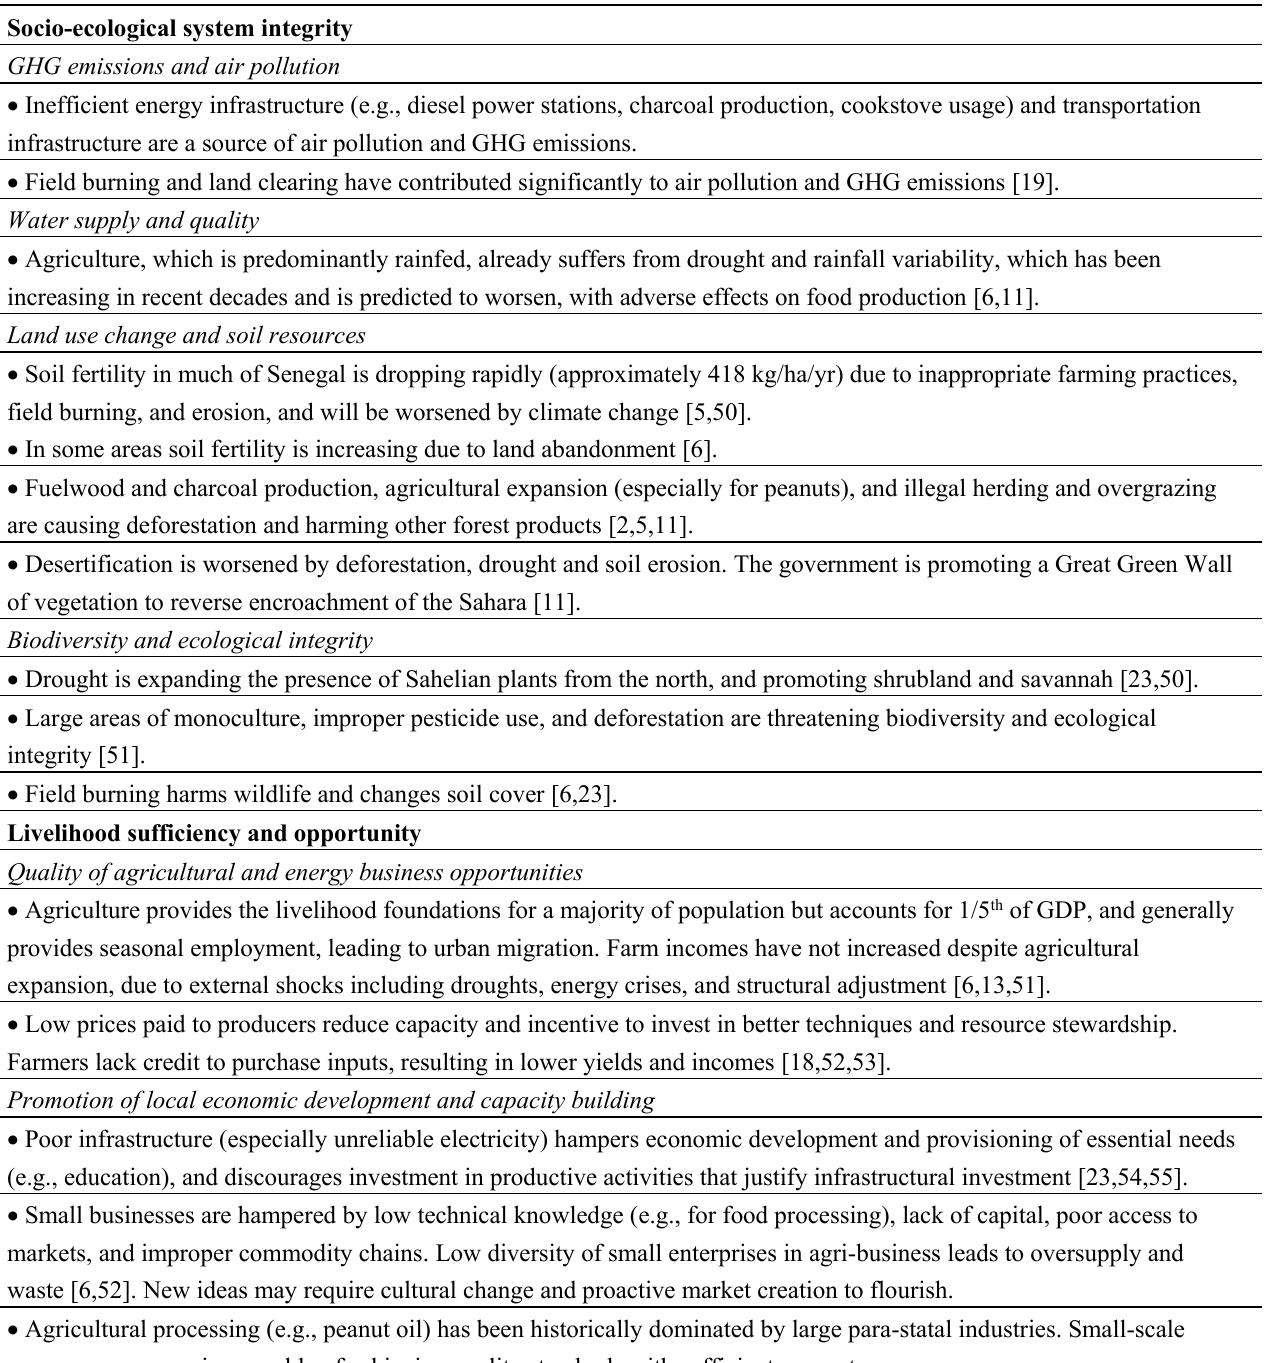
Table 3. Initial observations on the energy and agricultural systems of